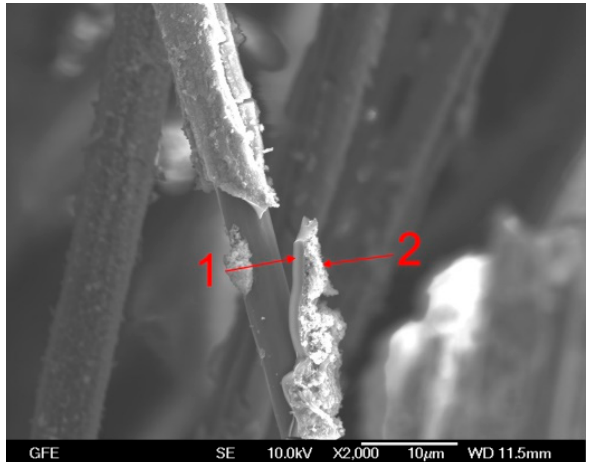
Figure 13. SEM image of unimpregnated carbon. 1 and 2 EDX analysis in the marked area.